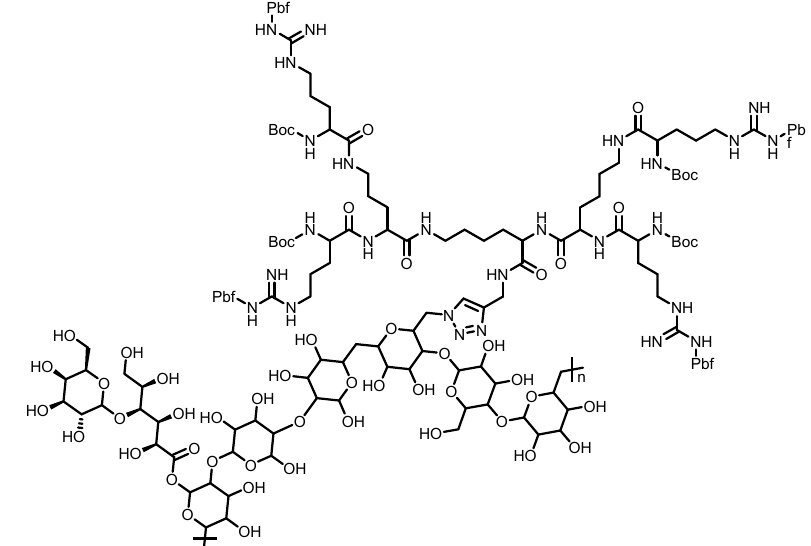
Figure 10. Chemical structure of LP-g-G3P an amphiphilic dendrimer [68].